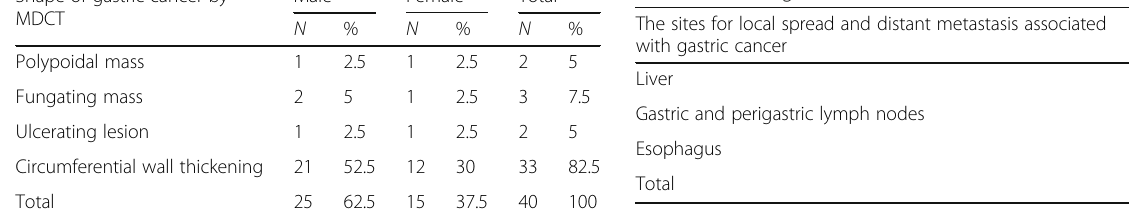
Table 3 The sites for local spread and distant metastasis associated with gastric cancer